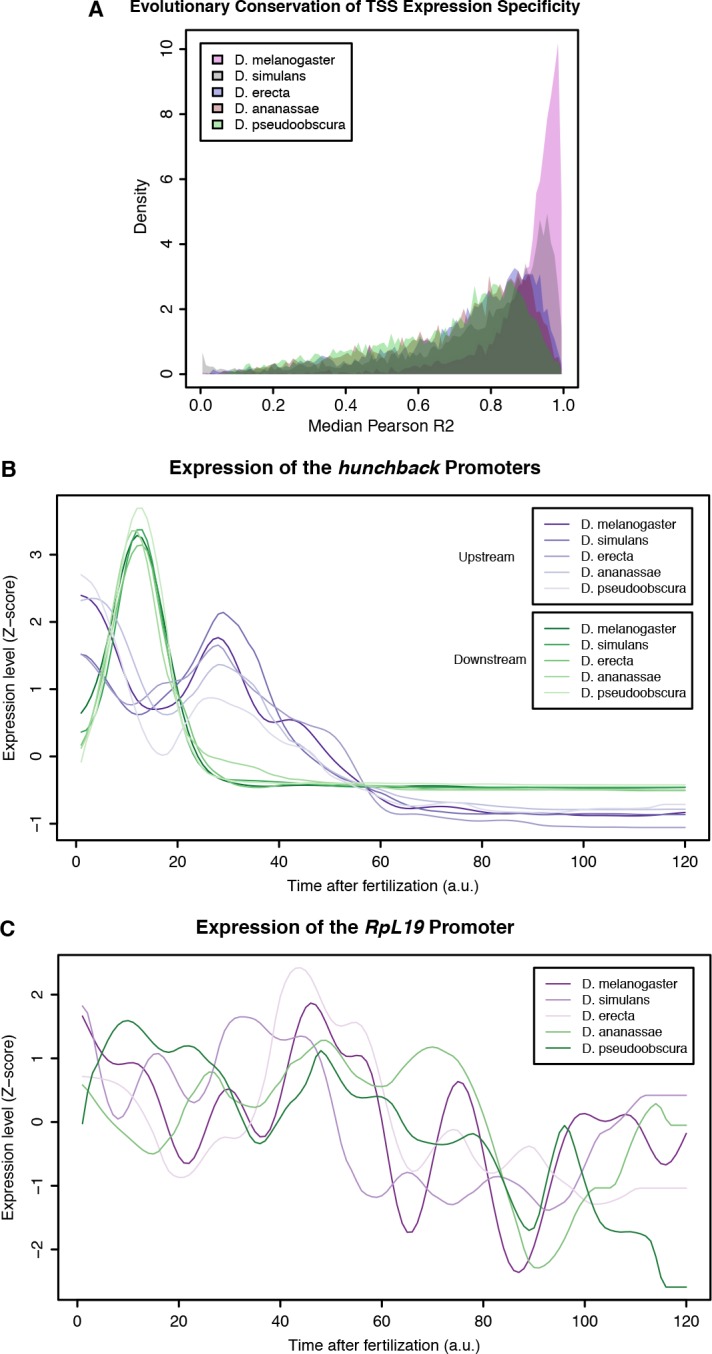
Evolutionary conservation of TSC expression profiles.(A) Distribution of average correlation coefficients for all orthologous TSCs between pairs of species. (B) Aligned expression profiles for the 2 promoters of the hunchback gene. (C) Aligned expression profiles for the RpL19 gene.